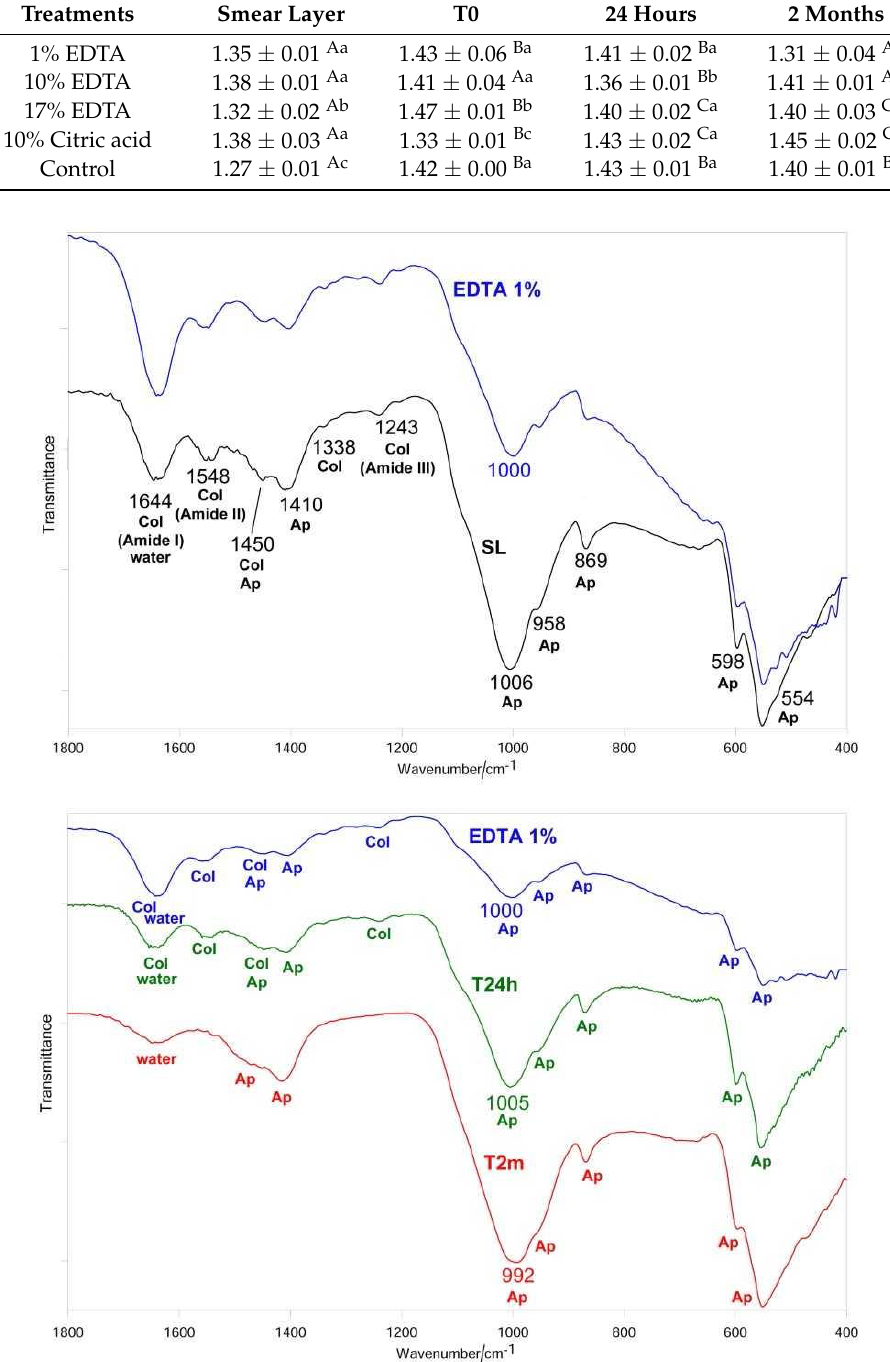
Figure 6. Average IR spectra recorded on the dentin surface after sanding (smear layer (SL), black), treatment with 1% EDTA (blue), aging in SBF for 24 h (T24h, green) and two months (T2m, red). The bands prevalently assignable to collagen (Col), water, and B-type carbonated apatite (Ap) are indicated.